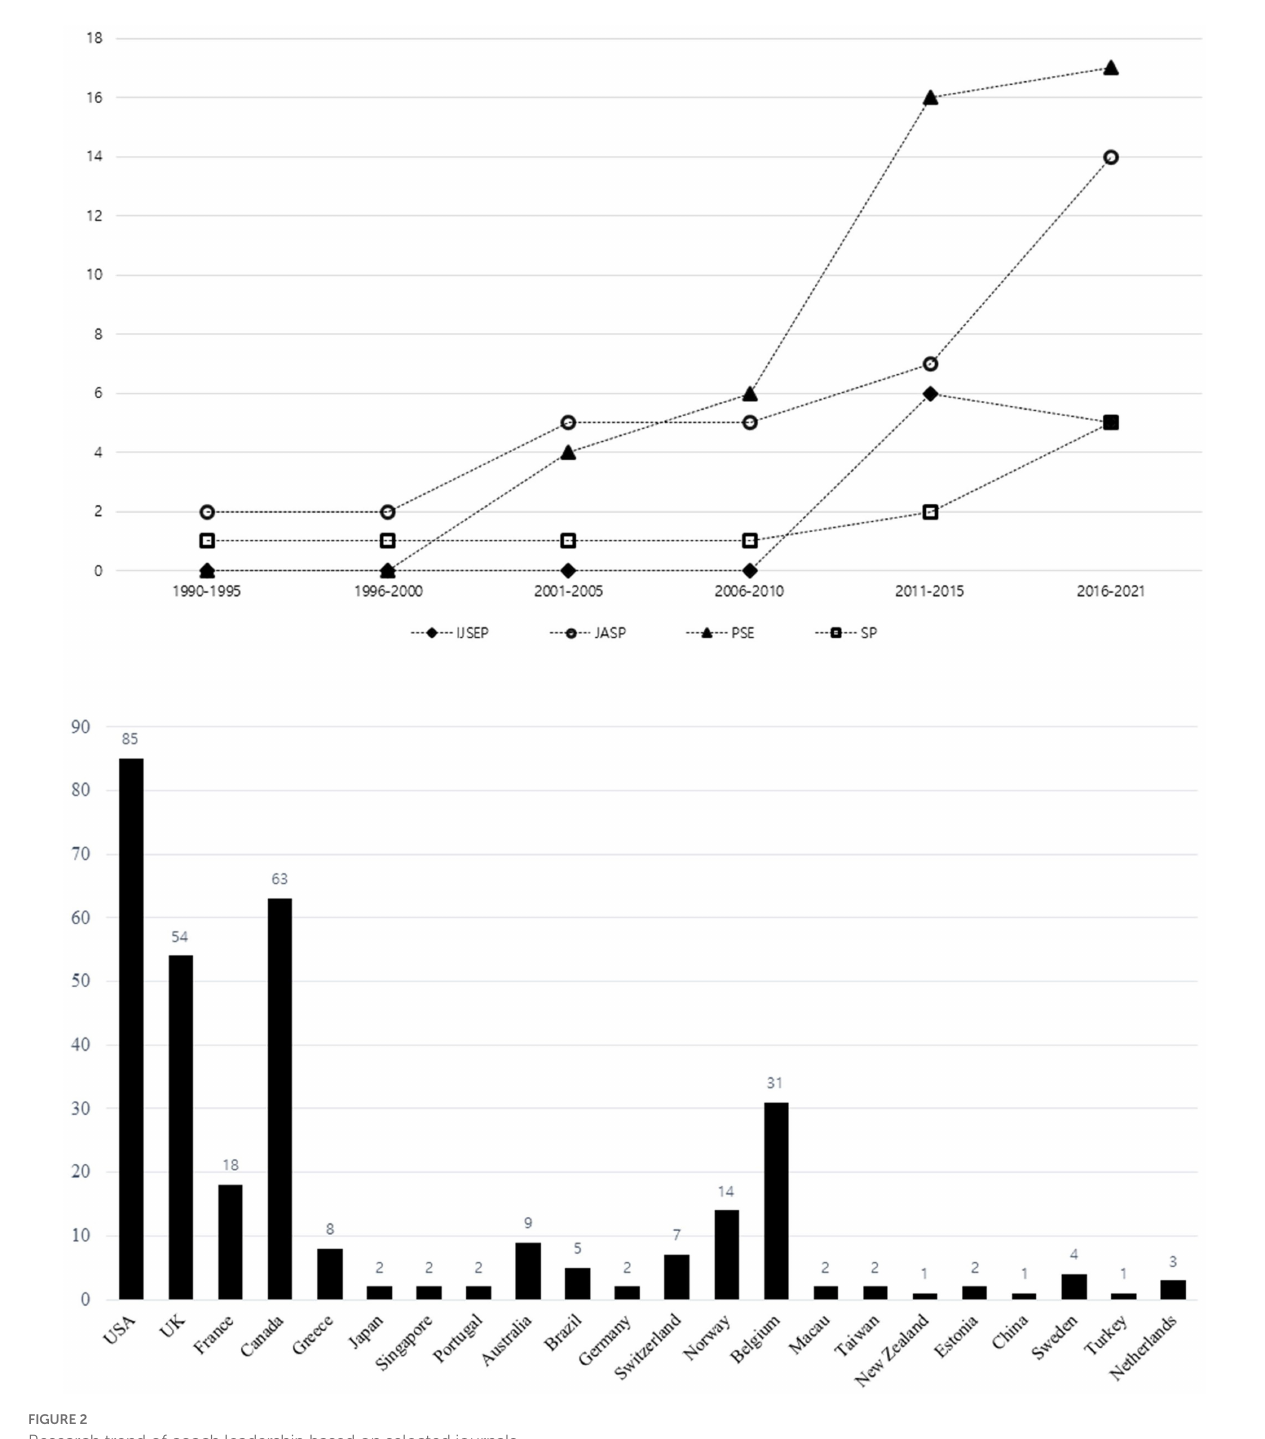
FIGURE 2 Research trend of coach leadership based on selected